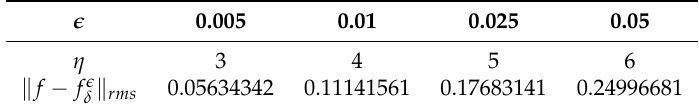
Table 3. Error norms, α =